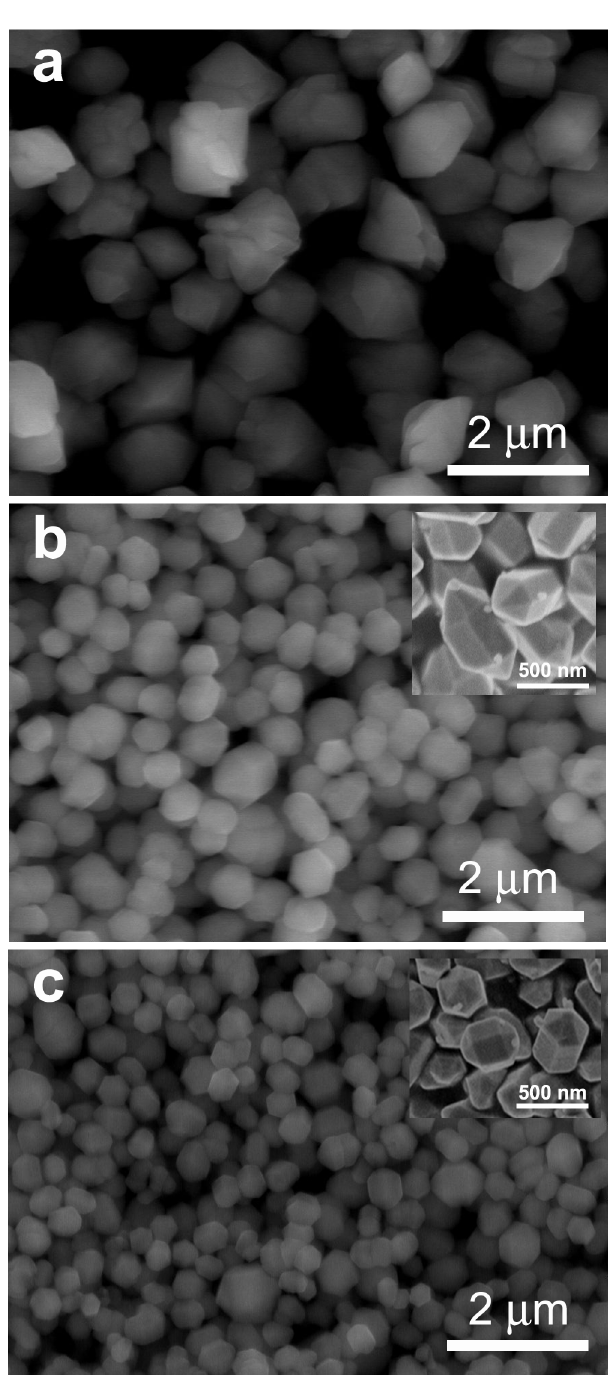
Figure 3. SEM images of β -NaYF 4 :Eu 3+ prepared without OA ( a ), with 5 mL OA ( b ), and with 5 mL OA + 2.5 mL C 2 H 5 OH ( c OA + 2.5 mL C 2 H 5 OH ( c ).